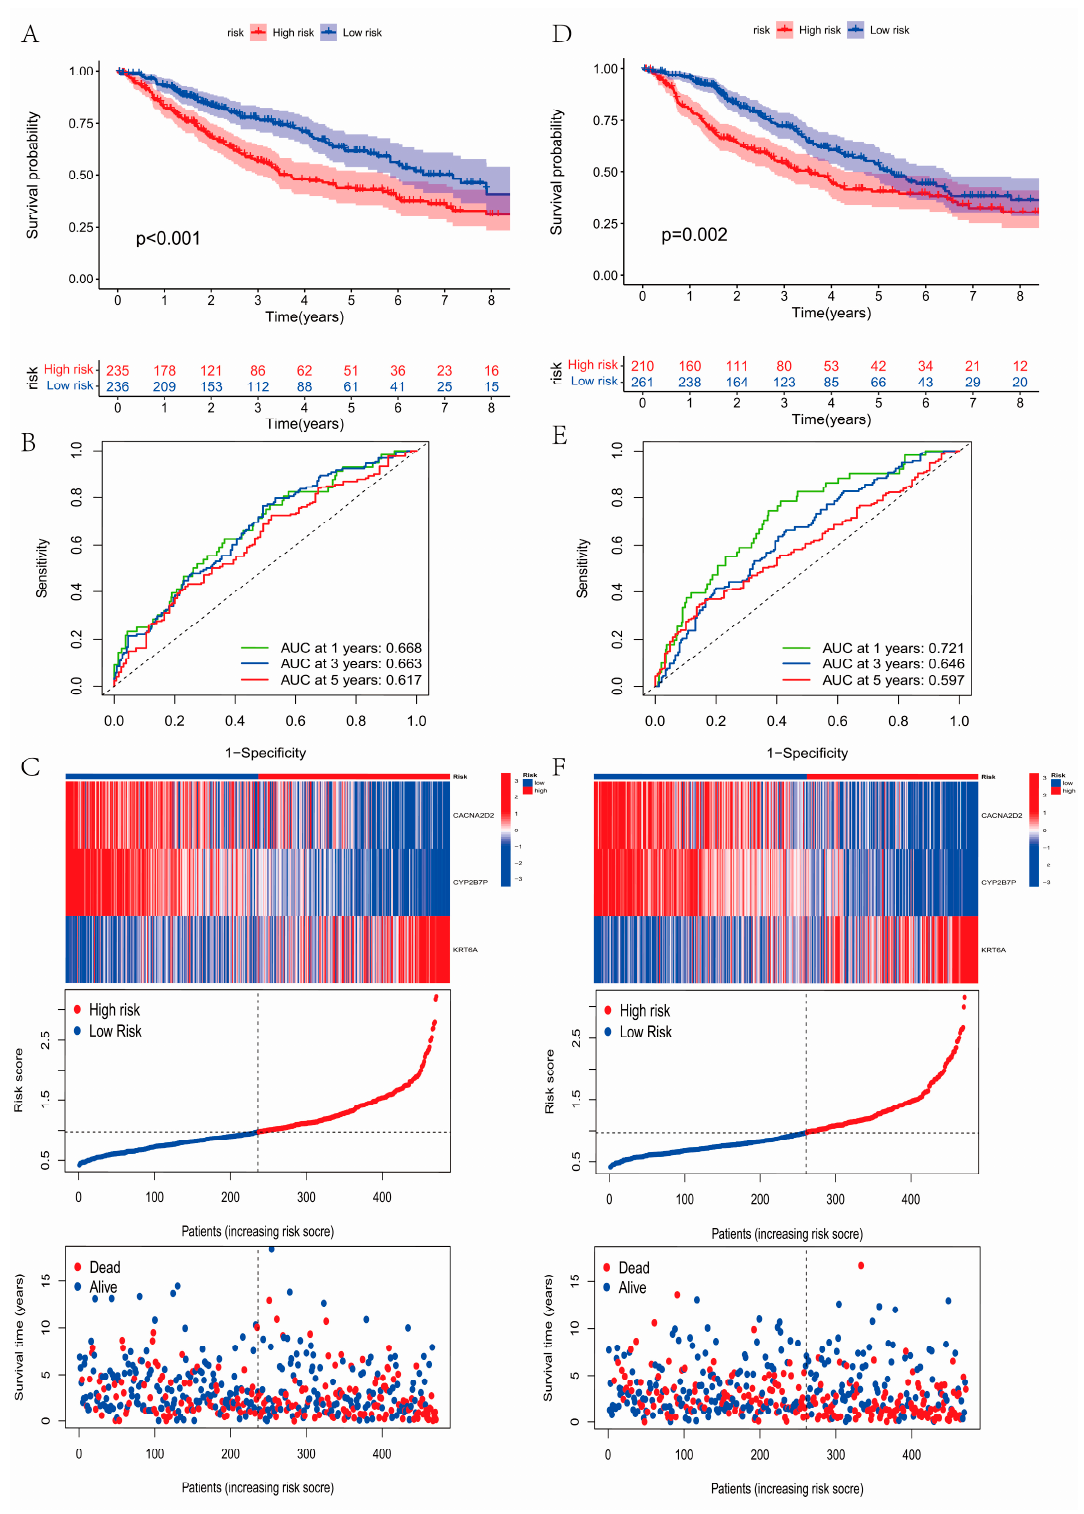
Figure 5. Construction and validation of the prognostic model. The differences in overall survival (OS) between high- and low-risk groups. The patients in low-risk group had significantly higher OS, using the Kaplan–Meier method and log-rank test (( A ), training group; ( D ), testing group). ROC curve measuring the predictive value of the risk score. The model showed better accuracy in predicting survival (( B ), training group; ( E ), testing group). The heatmap of the prognostic model (( C ), training group; ( F ), testing group).